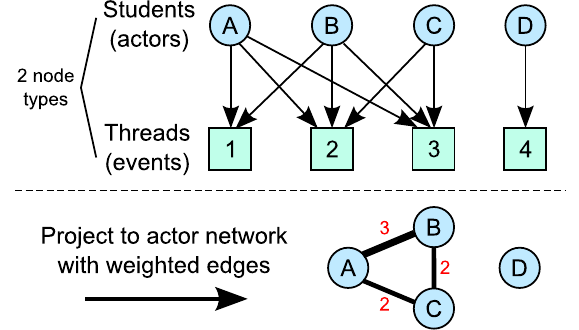
FIG. 2. Bipartite network model for transforming forum tran- script into a network object. Students are “ actor ” nodes, who post to thread or “ event ” nodes. The actor network projection links together student nodes who posted to the same